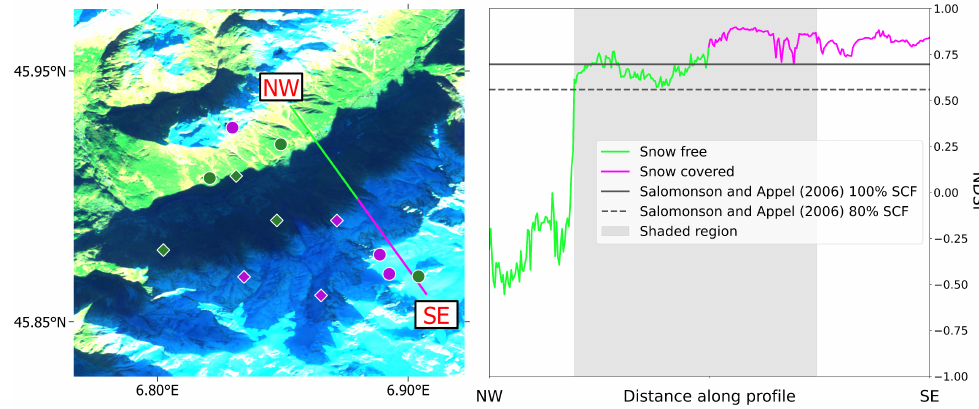
Figure 1. ( Left ): Sentinel-2B false colour composite (bands 11, 8A and 3) taken on 25 November 2020 at 10:33 AM UTC in the Chamonix valley in the European Alps (32TLR) with the RGB colours scaled from 0 to 0.25, 0 to 0.15 and 0 to 0.15, respectively. The round and diamond markers are placed in illuminated and shaded areas, respectively. The solar elevation angle is 26.5 ◦ . ( Right ): NDSI value along the profile line in the left image. The line colours indicate the snow-free (green) and snow-covered (pink) pixels along the profile. The shaded region is indicated with a grey background and the NDSI values for 80% and 100% SCF using FRA6T [17] are indicated with dashed and solid horizontal lines,